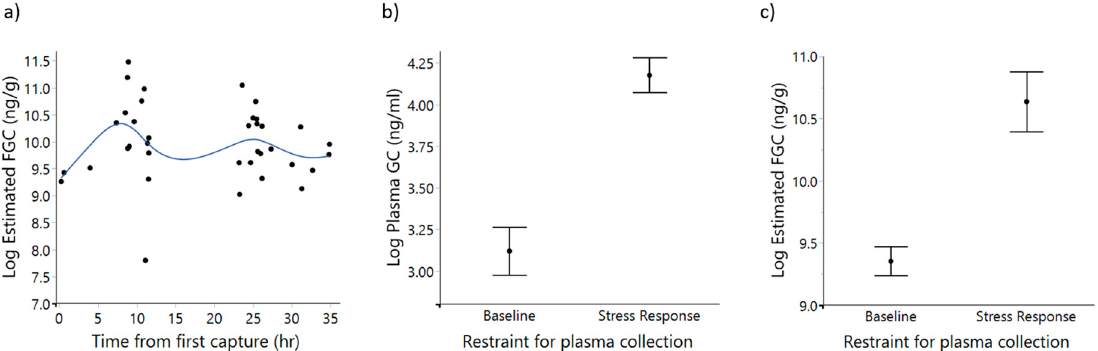
Figure 1. Glucocorticoids levels in fecal and plasma samples. A total of 12 individuals were used for this test with 6 males and 6 females. ( a ) Fecal glucocorticoids fluctuation same day of capture up to 40 h after first capture. Multiple samples per individual, with a total of 37 samples. ( b ) Plasma glucocorticoids levels before and after bleeding, n = 12, 6 males and 6 females. Figure shows means ± SE. ( c ) Fecal glucocorticoids levels before and after restraining for blood capture, n = 12, 6 males and 6 females. Figure shows means ± SE.